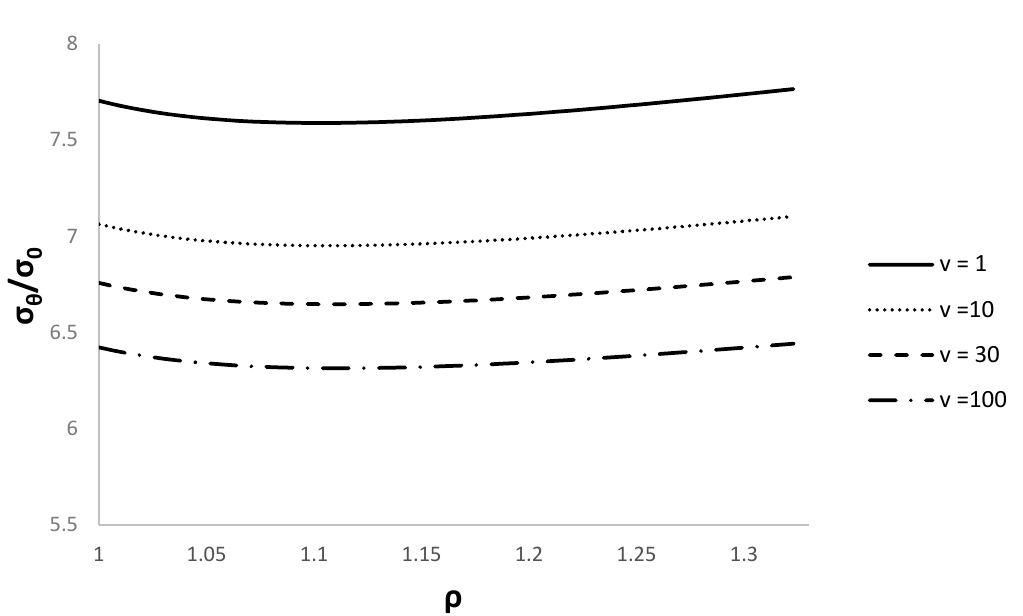
Figure 3. Radial distribution of the radial stress at α = 1 and several values of ν .